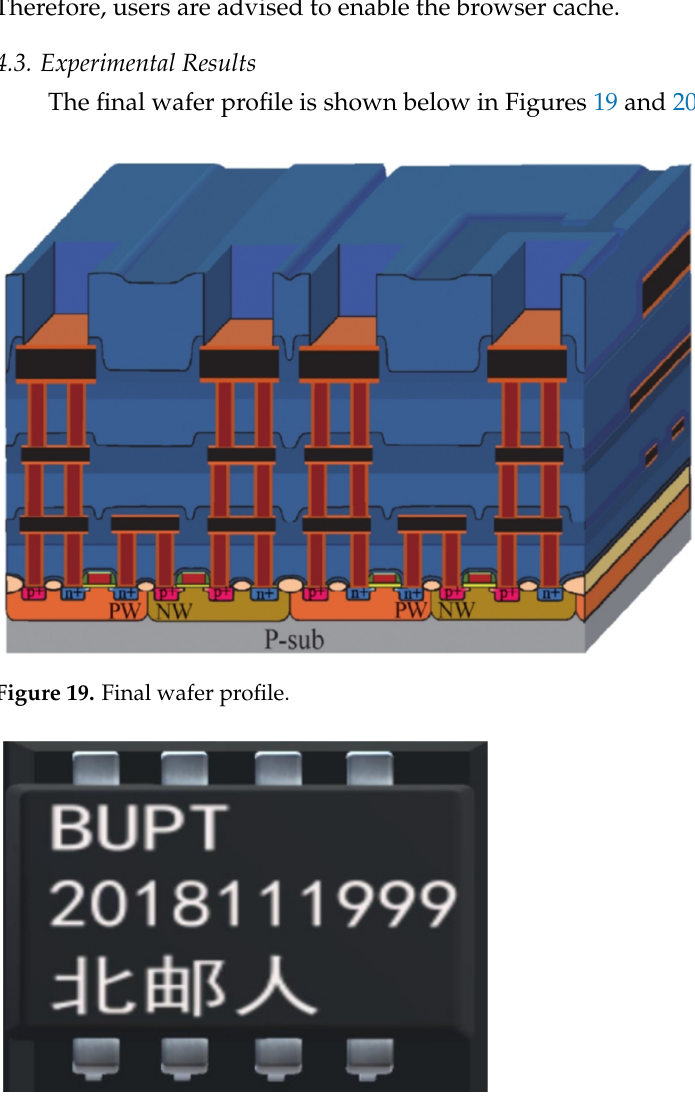
Figure 20. The result is a piece of inverter in a Dip8 package. The non-English part is the emblem, name or the website title of